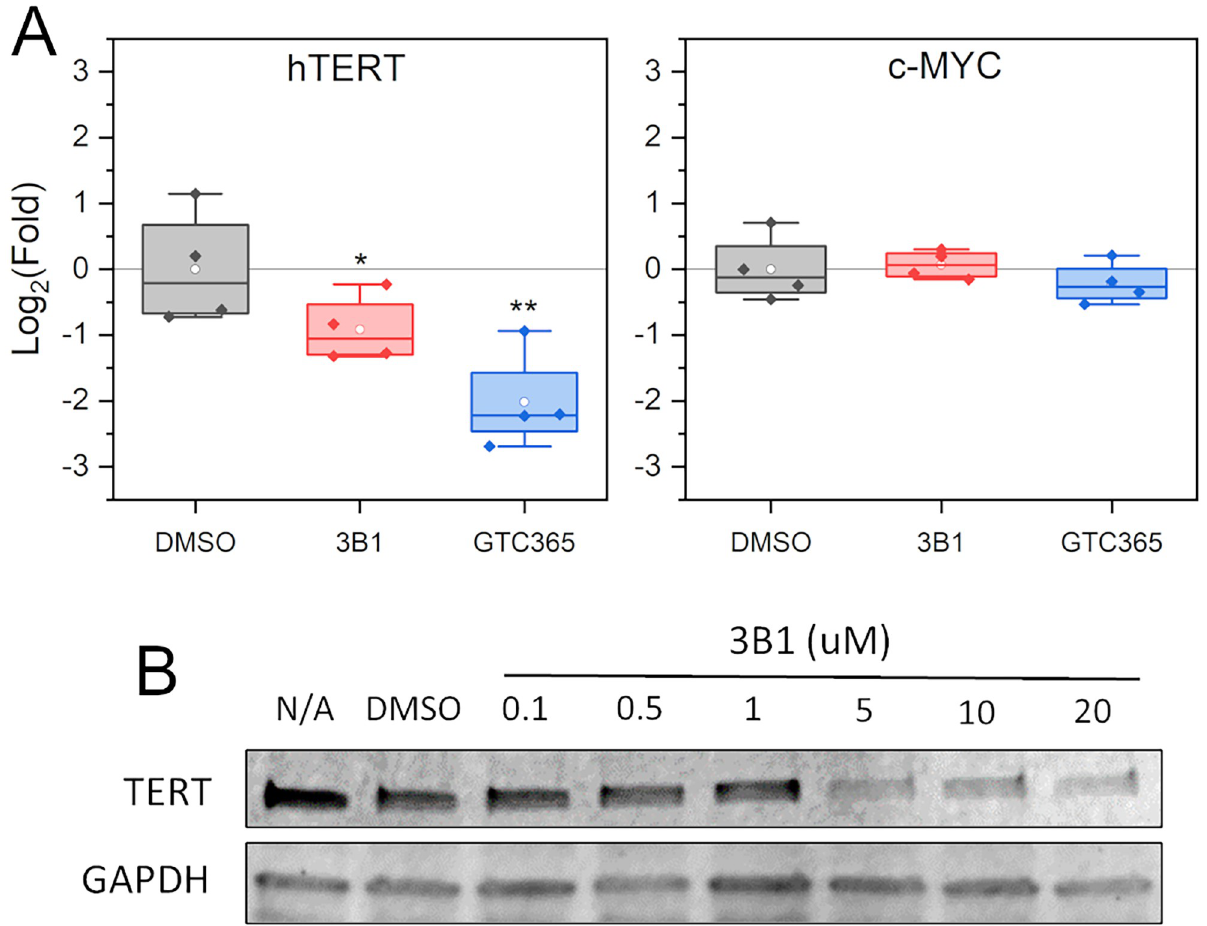
Fig 6. Real-time quantitative PCR and immunoblotting results. (A) qRT-PCR results of 3B1 and GTC365 (positive control) treatment of MCF7 breast cancer cells after 72hr. Media was replaced daily and contained either 10 μ M compound or DMSO as control. Results show average of triplicate measurements relative to GAPDH from four independent experiments. Statistical analysis was done using a 2-Way ANOVA and Tukey post-hoc testing (alpha level of 0.05, n = 4, � = P < 0.01, �� P < 0.001). (B) Immunoblot analysis and densitometry of hTERT protein after 72 hr. treatment with DMSO or compound 3B1 at the given